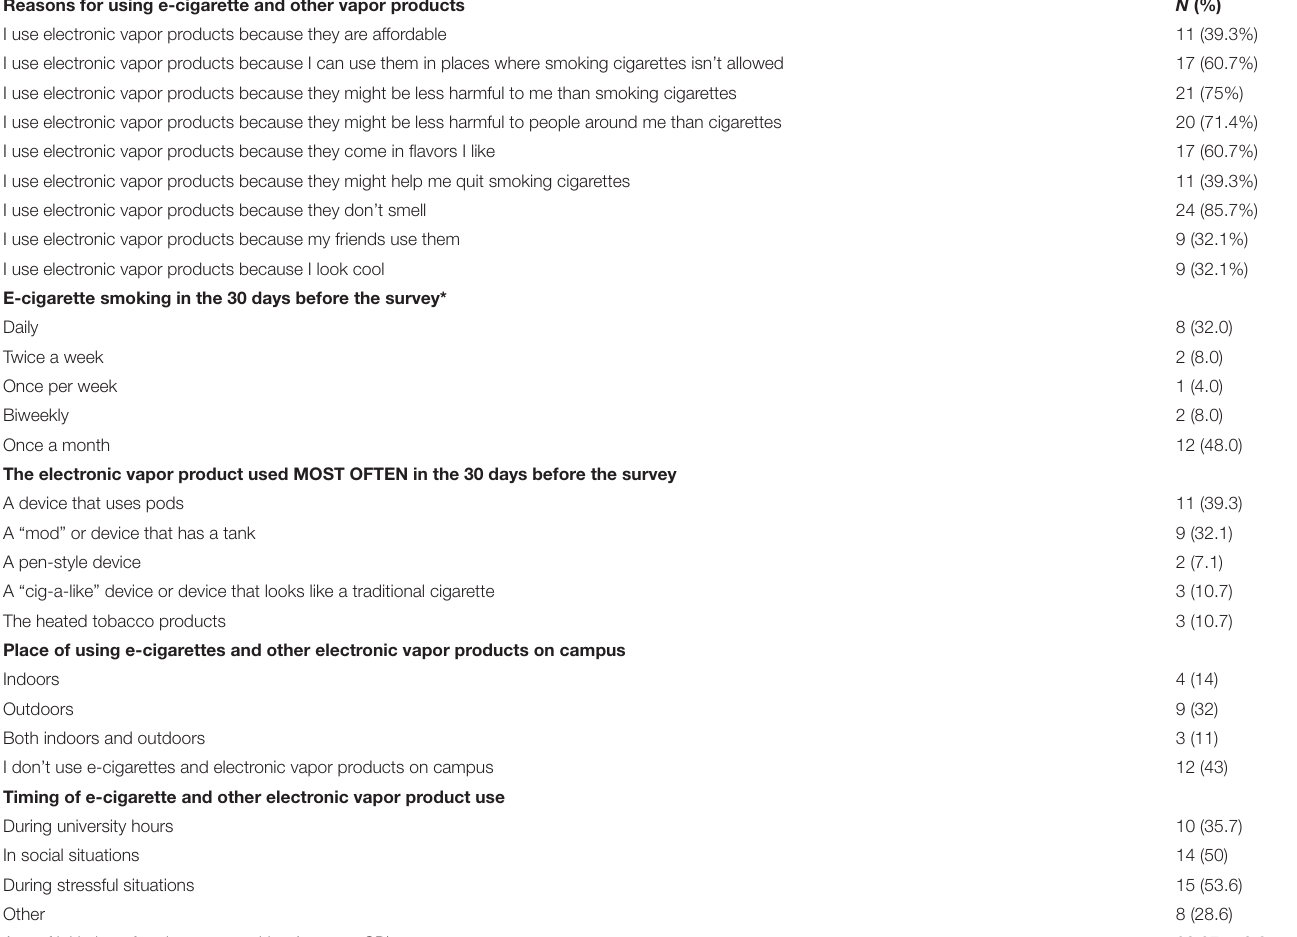
TABLE 3 | E-cigarette attitudes and practices among e-cigarette users. Reasons for using e-cigarette and other vapor